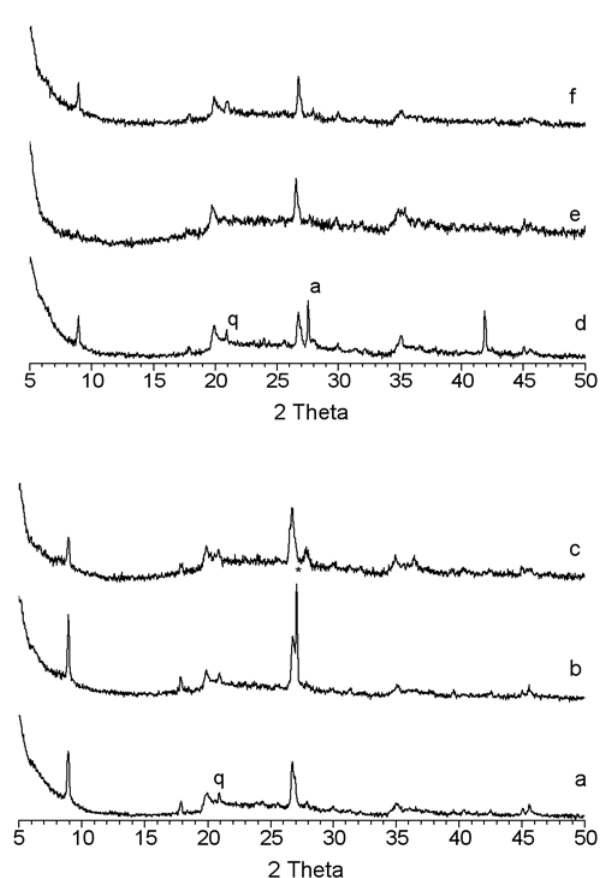
Figure 4. XRD in inert atmosphere of acid treated montmorillonites (a)